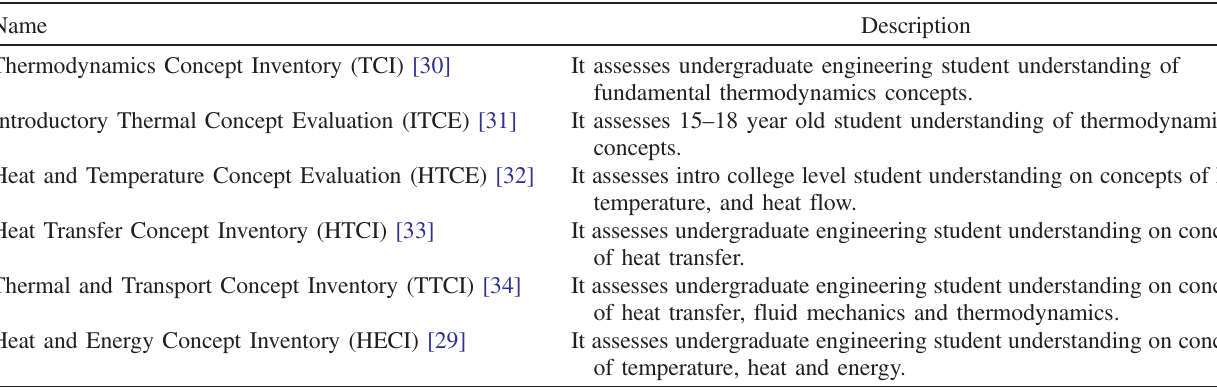
TABLE I. The names and descriptions of concept inventories in the area of